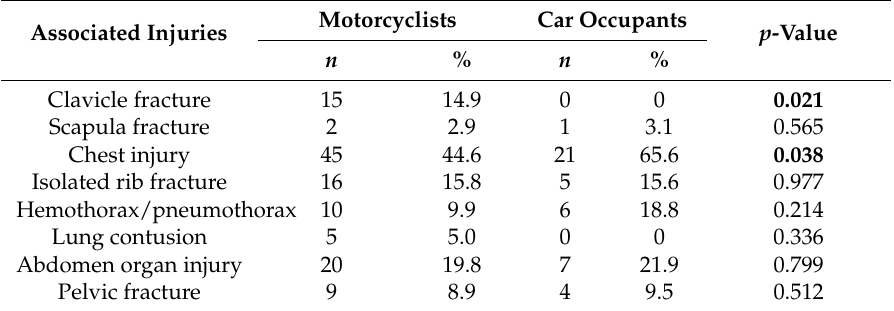
Table 3. Associated injuries in thoracoabdominal regions of motorcyclists and car occupants with high-grade